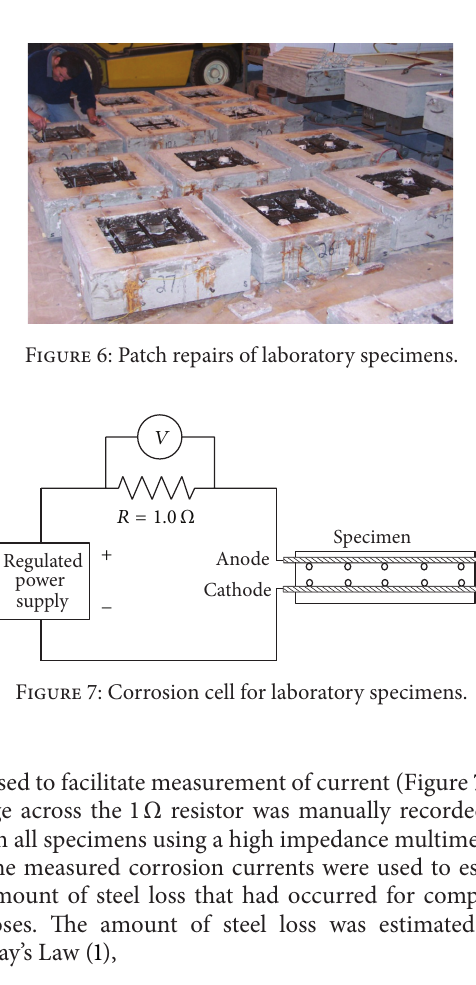
was used to facilitate measurement of current (Figure 7). The voltage across the 1 Ω resistor was manually recorded each day on all specimens using a high impedance